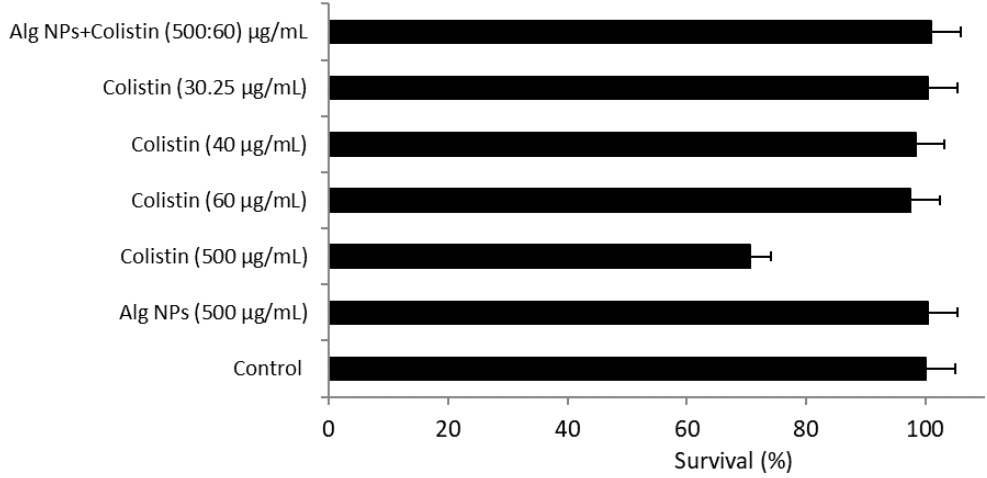
Figure 4. Cytotoxicity of the different colistin formulations on HT-29 cells.